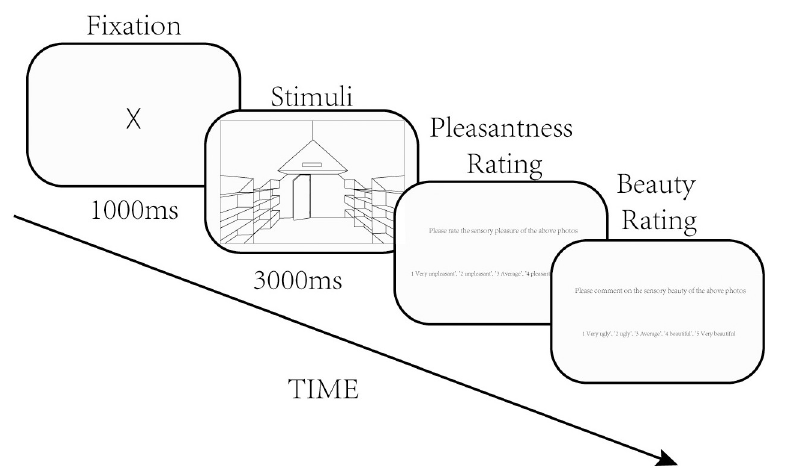
Fig 2. Experimental